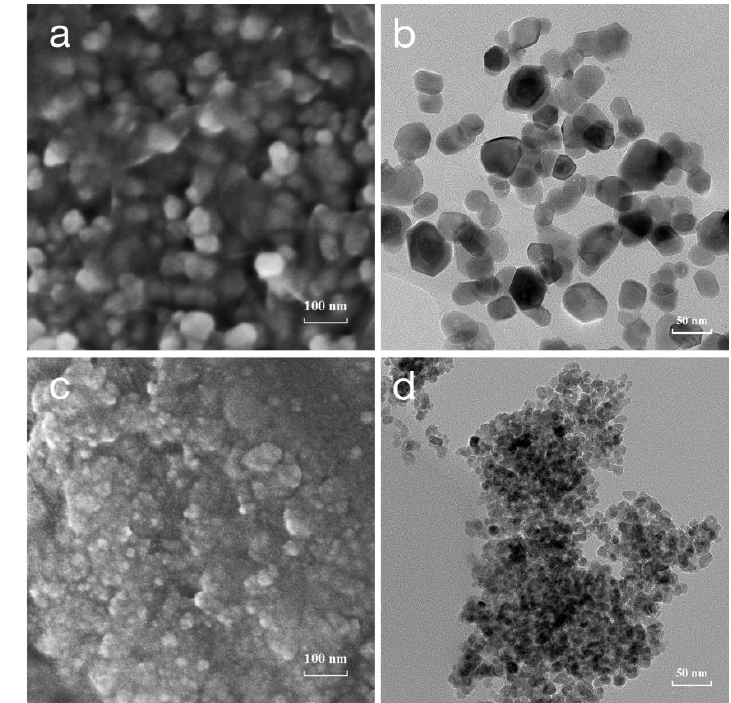
Figure 1. SEM and TEM images of Co 3 O 4 ( a , b ) and Co 2 Ti 1 ( c , d ).